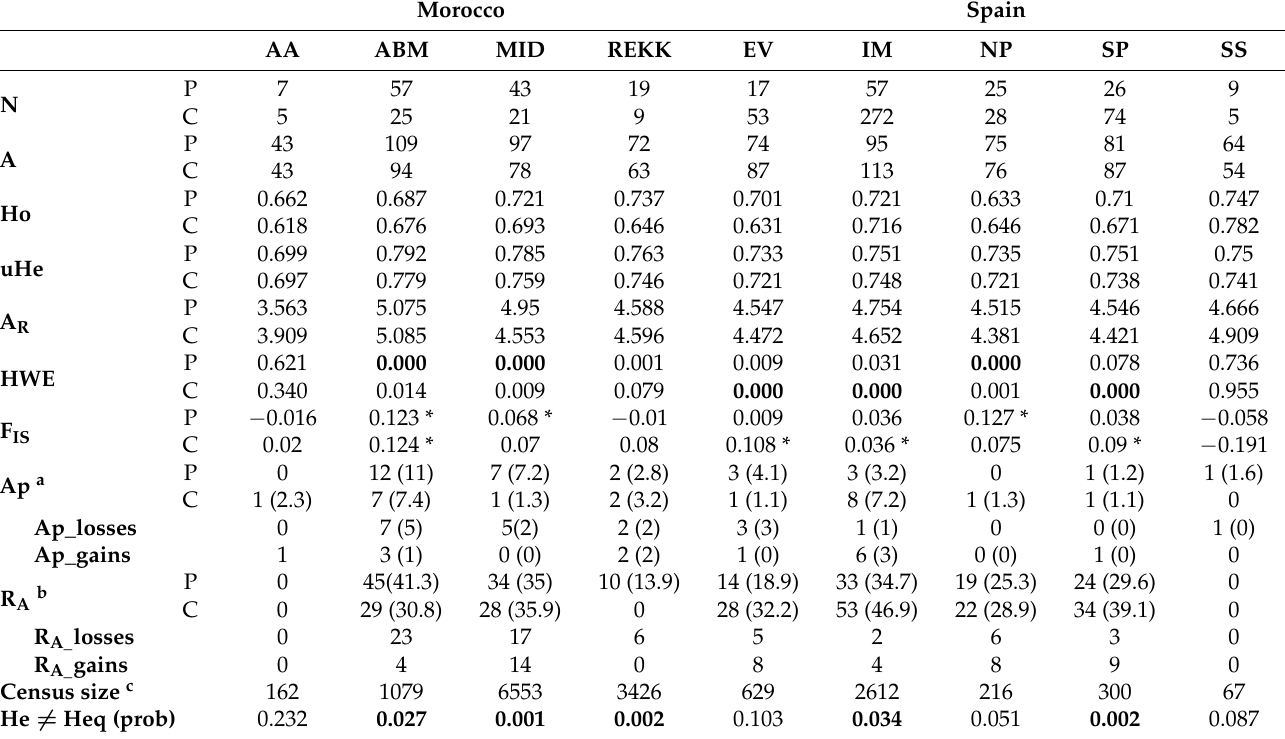
Table 1. Genetic diversity estimates for each of the nine Dupont ´ s lark regions during the recent past (P) and the current (C) sampling periods, showing sample size (N), number of alleles (A), observed heterozygosity (H o ), unbiased expected heterozygosity (uH e ), allelic richness (A R ), p values for Hardy–Weinberg equilibrium (HWE) tests (significant values after Bonferroni correction in bold), inbreeding coefficient (F IS ), number and percentage (in brackets) of private alleles (Ap), and number and percentage of rare alleles (R A ). Significant F IS values are represented with an asterisk. The number of private and rare alleles lost (Ap_losses/R A _losses) and gained (Ap_gains/ R A_ gains) is indicated (see main text for further details of calculations). Of the Ap_losses count, those that are completely lost at the metapopulation level in the current period are in brackets. Of the Ap_gains count, those already detected in any other region in the recent past period are in brackets. The population size (census size) of each region is also indicated. The result of the bottleneck analysis, using the two-phase mutation model (TMP) and the Wilcoxon 1-tailed test for heterozygosity excess is also shown (significant results in bold). Region codes as in Figure 1. See Supplementary material, Table S2 for further information about allele